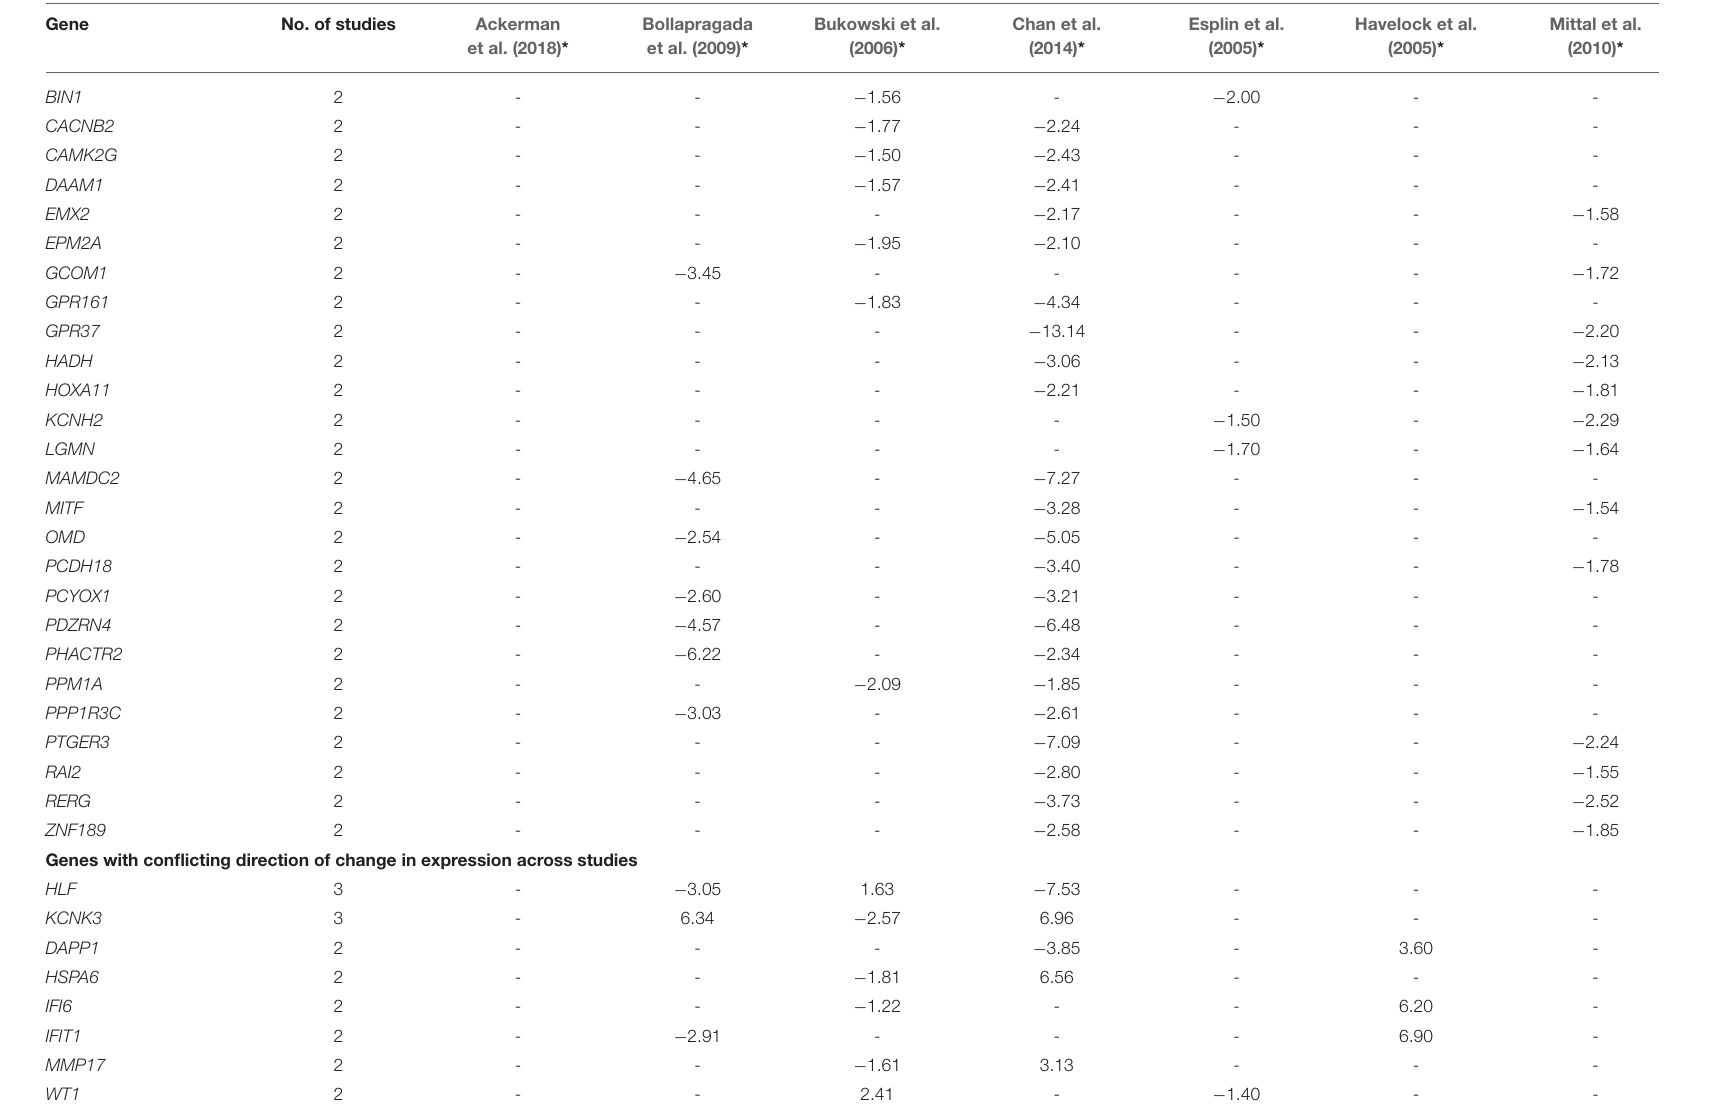
- - - 2 - - 2.41 - − 1.40 - - * Show in column 3 onwards are fold-change value of RNA levels during labor. A positive value represents an increased RNA level during labor, while a negative value represents a decreased